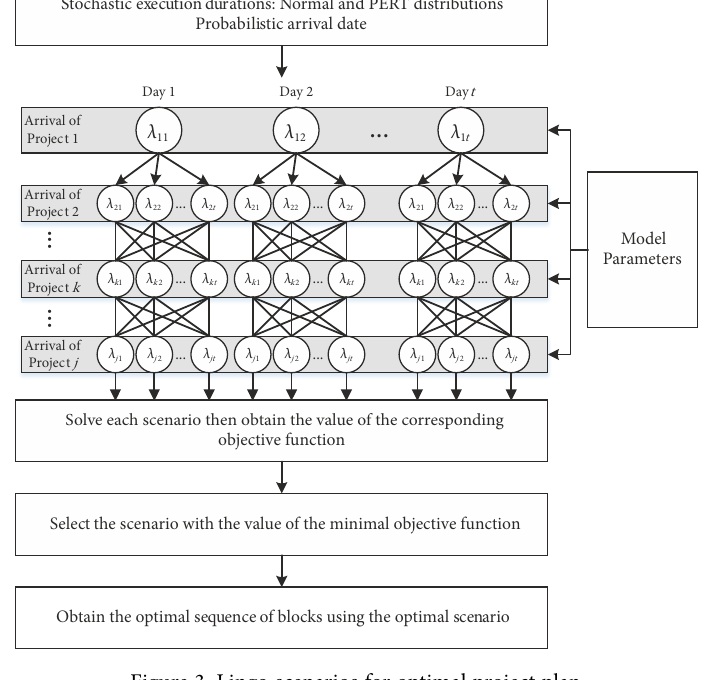
Figure 3. Lingo scenarios for optimal project plan